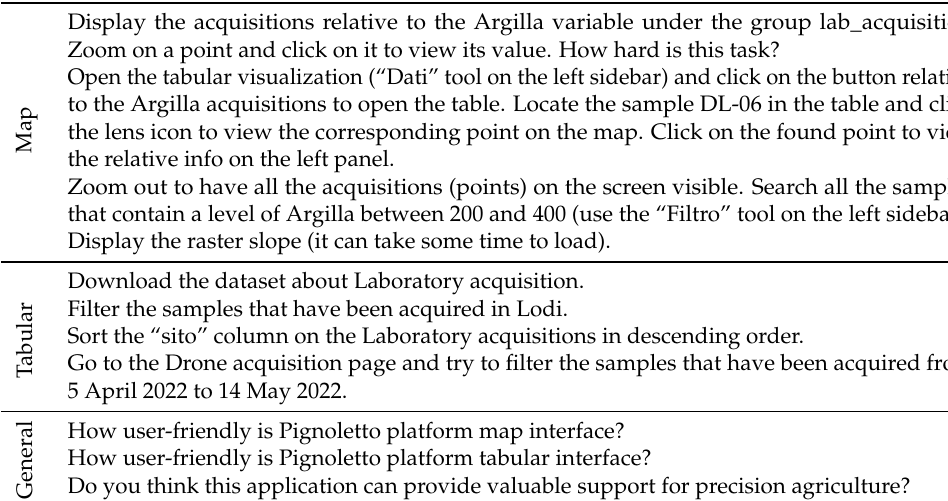
Table A1. Task-driven